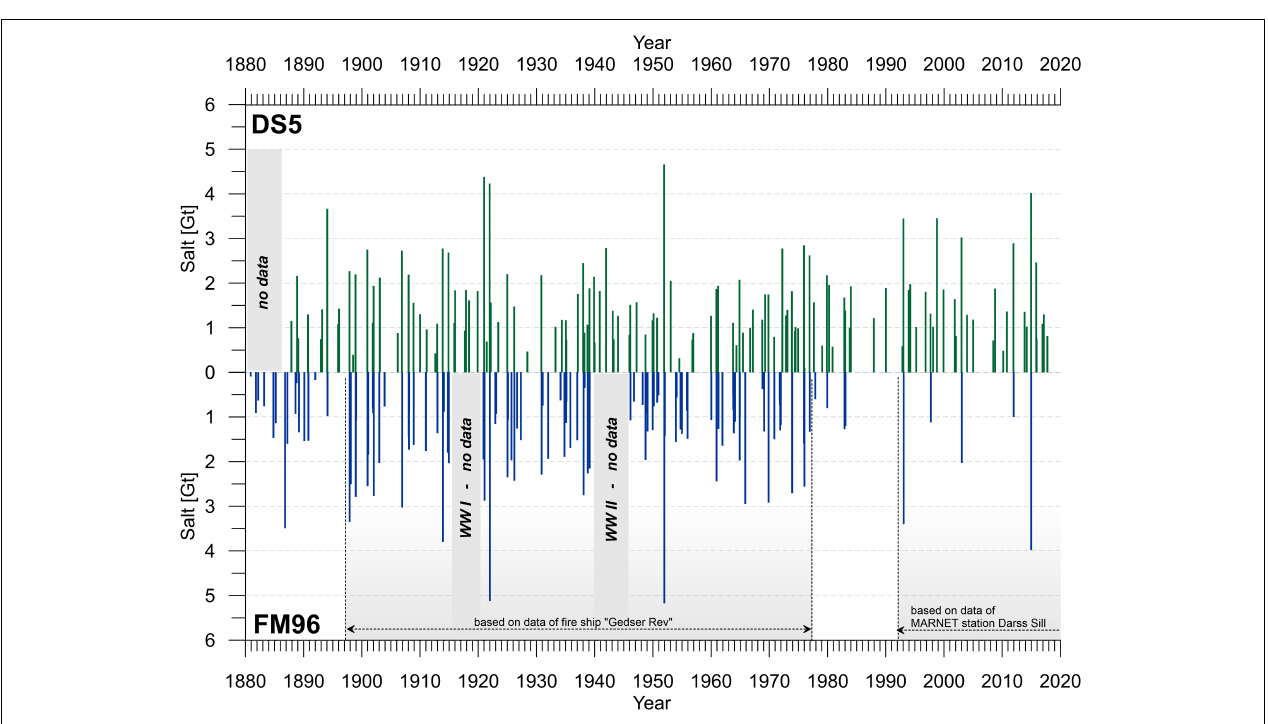
FIGURE 9 | Comparison of MBI sequence DS5 (top) with FM96 (bottom) . Gray areas indicate periods with no data. At the bottom the availability of time series observation at Gedser Rev and Darss Sill is